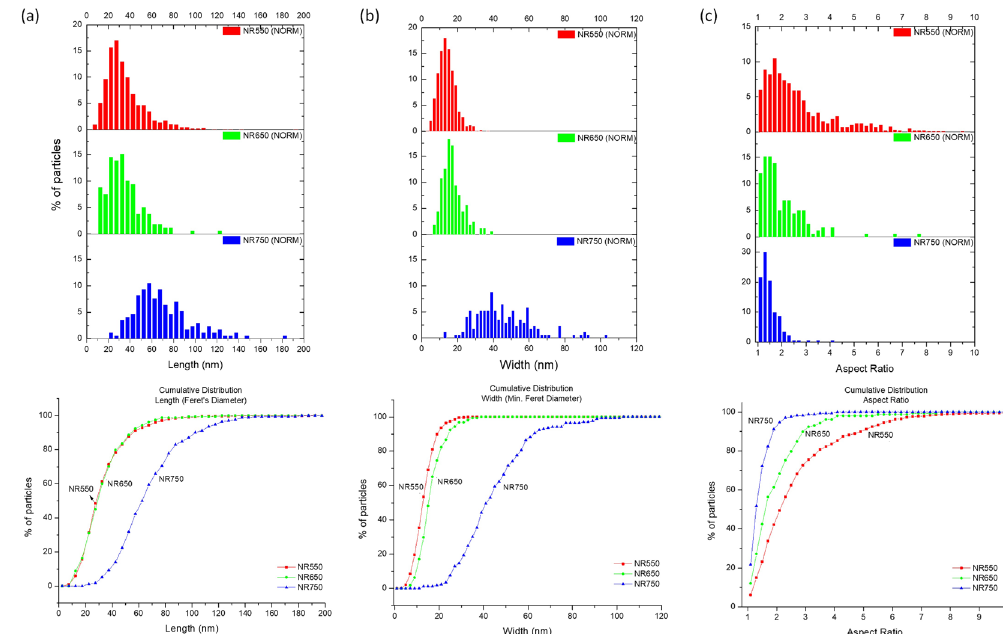
Figure 4. Comparative Histogram (top) and cumulative distribution (bottom) of particle’s length (a), width (b) and aspect ratio (c) obtained from TEM analysis of samples NR550, NR650 and NR750.